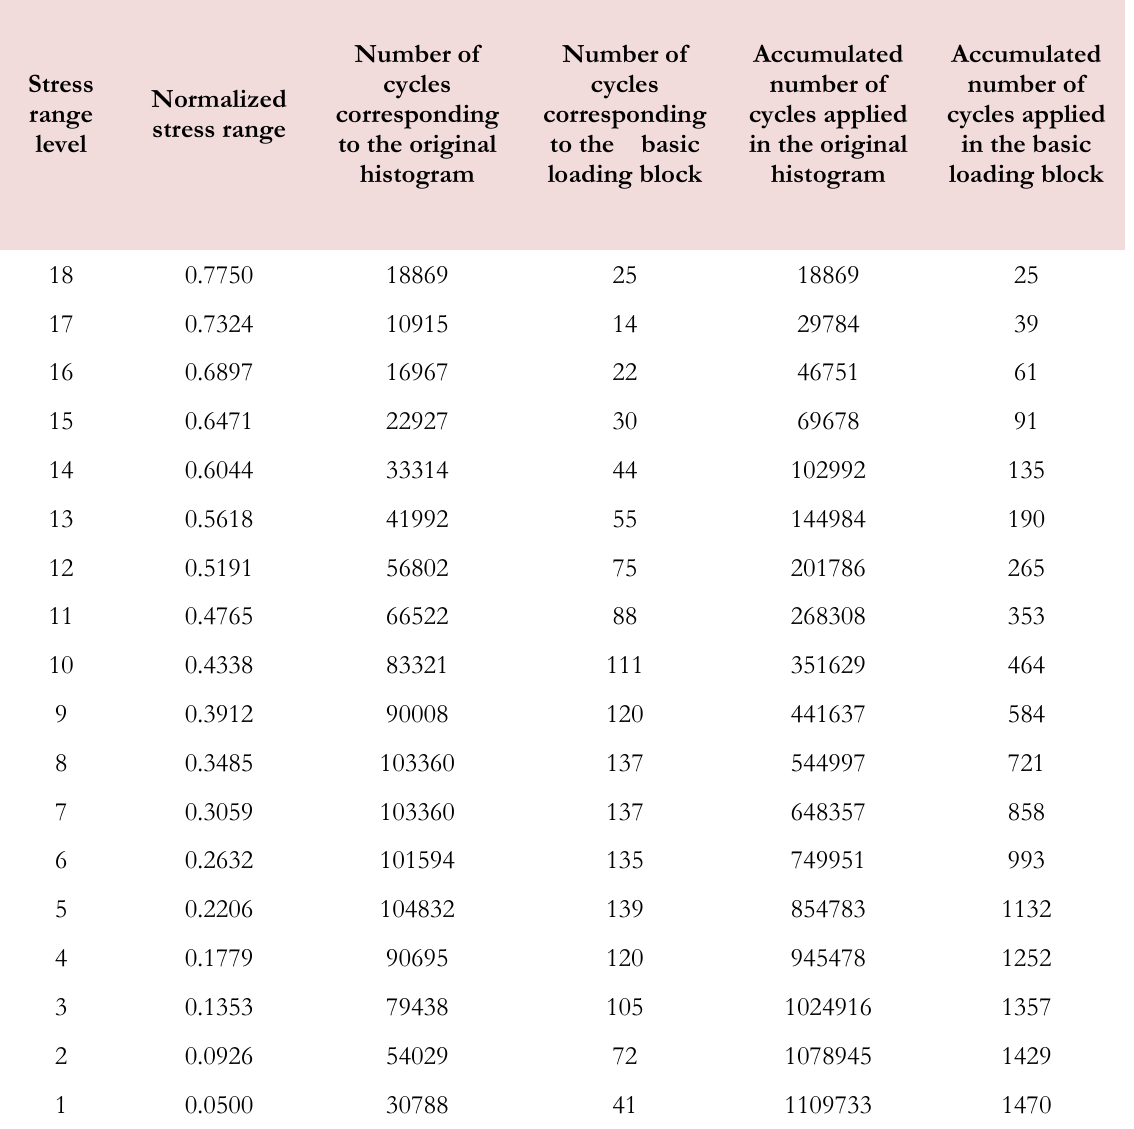
Table 2: Stress ranges corresponding to the 18 levels considered in the load collective and number of cycles in the original block and basic stress